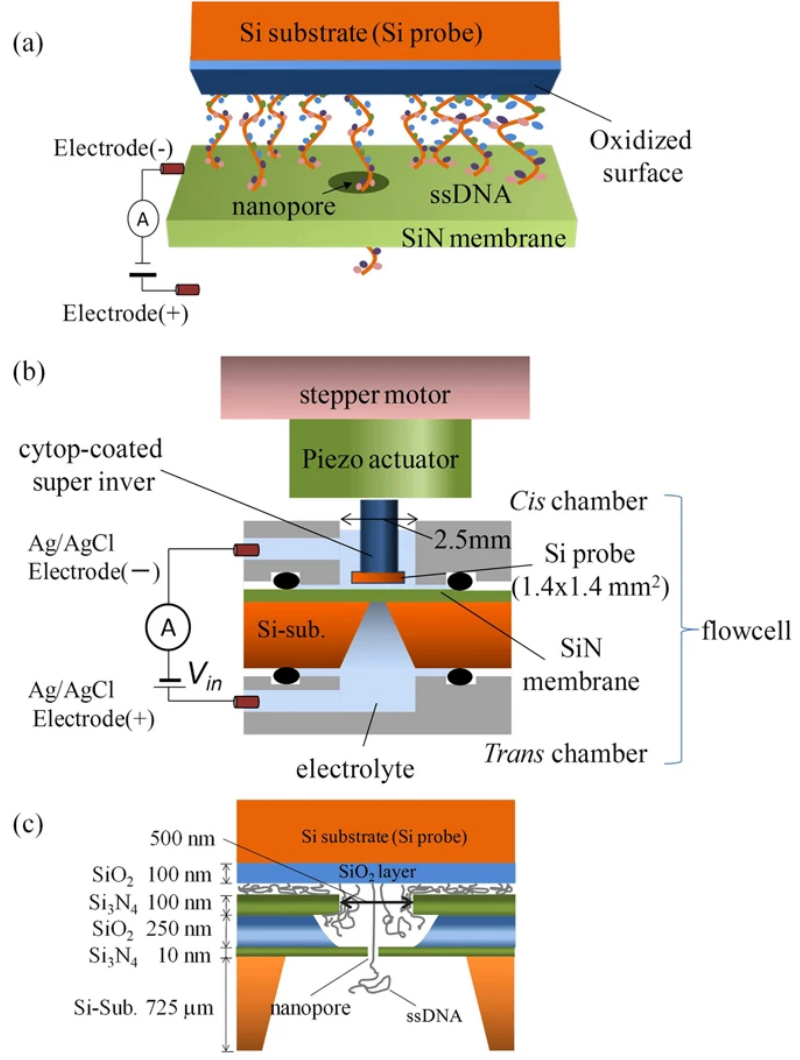
Figure 5. Schematic representation of immobilizing the DNA strands on a probe and using the system for sequencing purposes. ( a ) shows a cartoon of ionic current measurement when the probe remains in the nanopore. ( b ) Scheme of the measurement setup. ( c ) Zoomed-in schematic for around the nanopore. This scheme is reproduced from